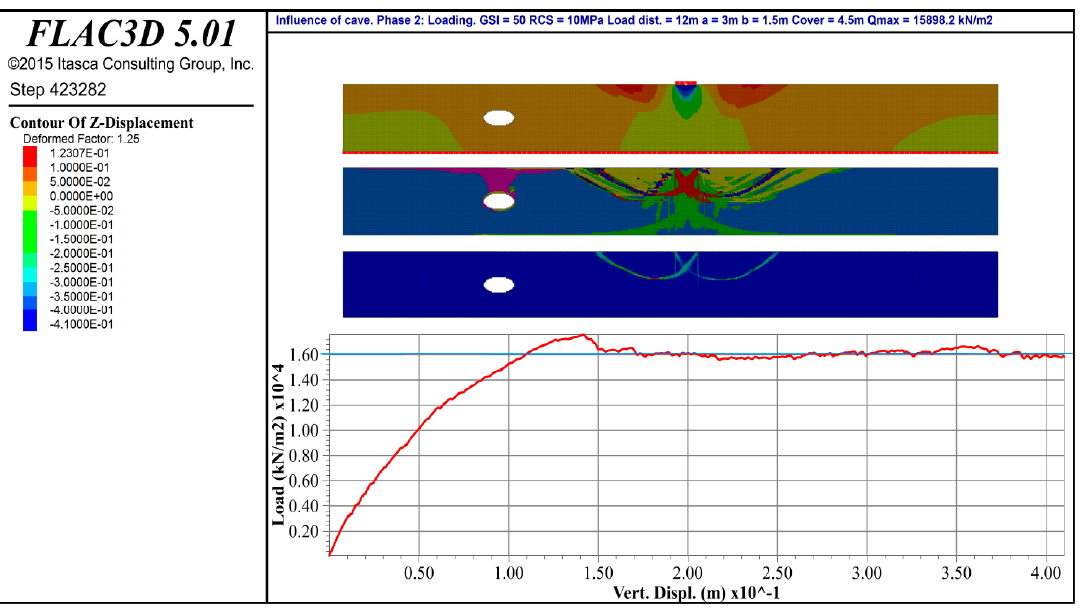
Figure 5. Case IEH-2. Eccentricity E/a = 6 (still a mixed failure mechanism, but with a clear predominance of classic plastic-failure wedge formation on both sides of the footing. Little influence of the cavern).